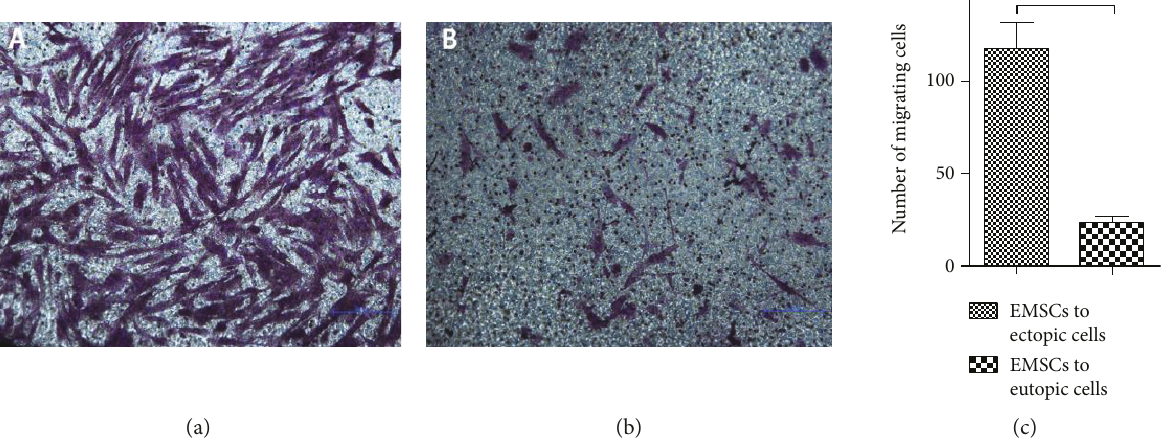
Figure 2: EMSC migration towards endometriosis in vitro. (a) EMSCs migrated towards ectopic endometrial cells in vitro. The cells were counted by microscopy. Scale bar =200 μ m. (b) EMSCs migrated towards EUECs in vitro. The cells were counted by microscopy. Scale bar =200 μ m. (c) Diagram of EMSC tropism to endometriosis in vitro. The EMSCs revealed a signi fi cantly higher tropism to the ectopic endometrial cells of patients with endometriosis than to the control eutopic cells. The error bars, standard deviation, and P values were determined using the two independent samples t -test; ∗∗∗ P < 0 001 .